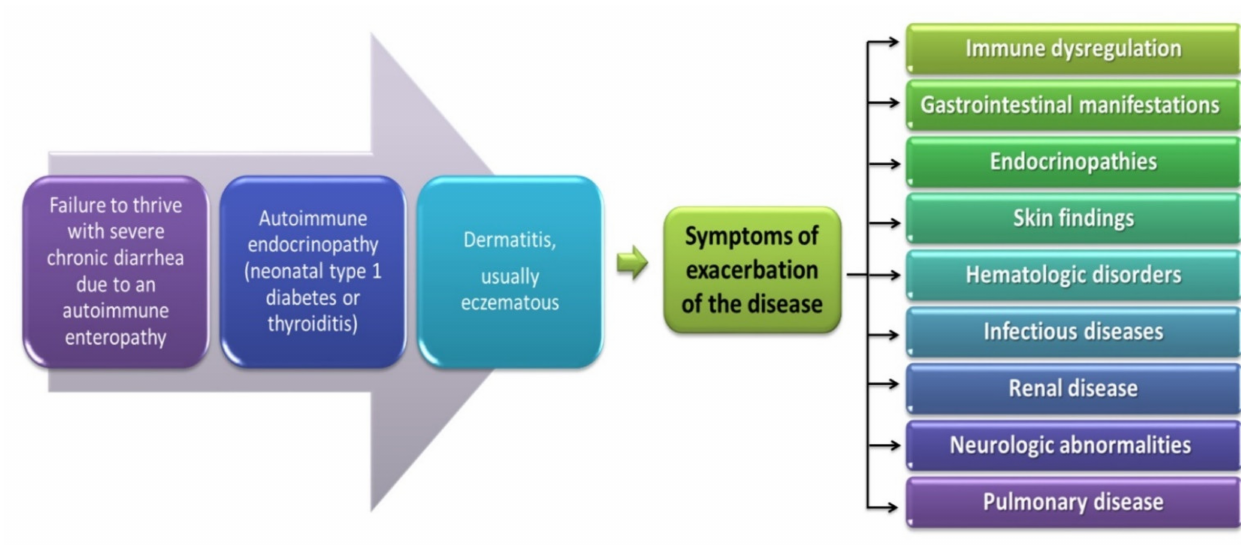
Figure 5. Symptoms of IPEX developed from [177].